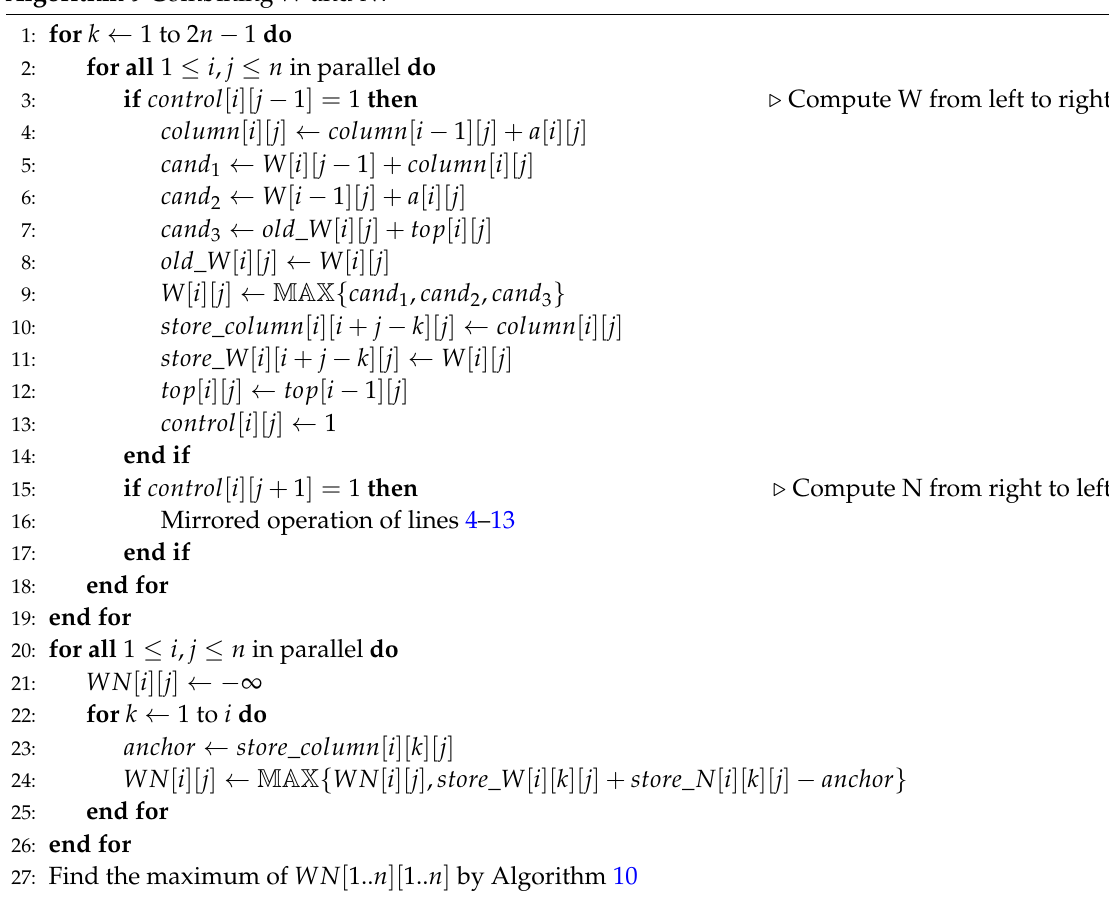
Algorithm 9 Combining W and N .